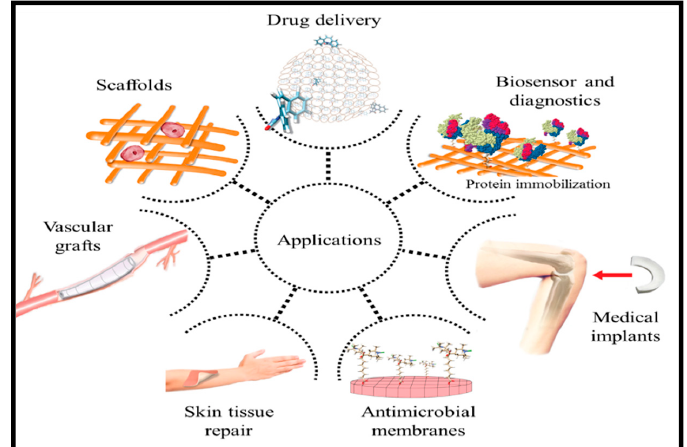
Figure 5. Biomedical application of cellulose-based materials [88].